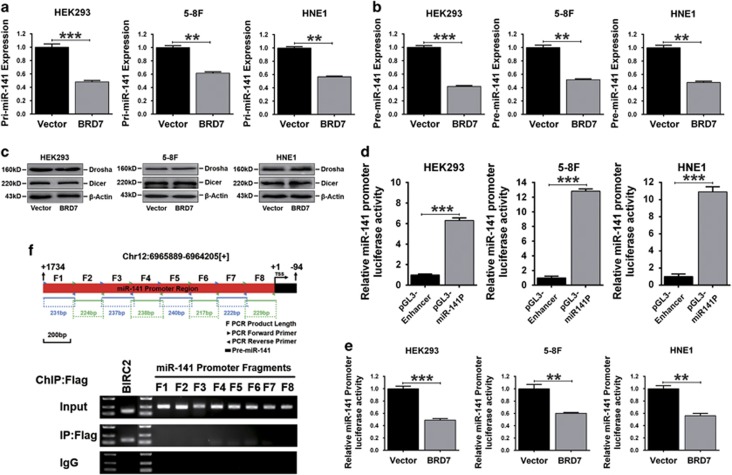
BRD7 downregulated the expression of miR-141 by repressing its promoter activity in HEK293, 5-8F and HNE1 stable cell lines. (a) The expression of pri-miR-141 and (b) pre-miR-141 was determined by qRT-PCR. GAPDH and U6 served as internal controls for pri-miR-141 and pre-miR-141, respectively. (c) Drosha and Dicer protein levels were detected by western blot. β-Actin served as an internal control. (d) The dual-luciferase reporter system assay evaluated the miR-141 potential promoter activity in HEK293, 5-8F and HNE1 cell lines and (e) in BRD7-overexpressing stable cell lines, normalized to pRL-TK. (f, upper panel) A schematic diagram showing the location of the miR-141 potential promoter region on chromosome 12 and the locations of the PCR primer pairs for the ChIP assay, and (f, lower panel) ChIP-PCR analysis for binding fragments of BRD7 within the miR-141 potential promoter region. BIRC2 was used as a positive control. F1–F8 represent the eight fragments in the miR-141 potential promoter of the PCR product. (a, b, d and e) The error bars are presented as the mean±S.E.M. **P<0.01, ***P<0.001. All experiments were performed in triplicate